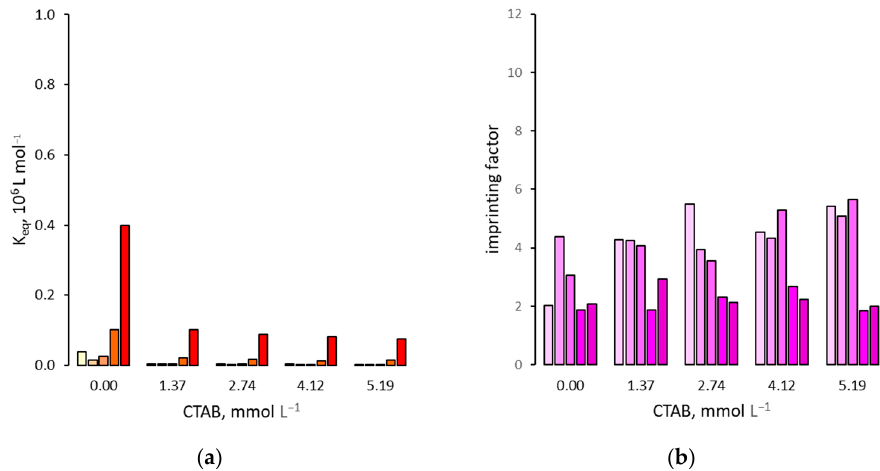
Figure 6. ( a ) Binding affinity of 2,4,5-T for the NIP in presence of increasing amounts of CTAB; ( b ) Imprinting factor. For each group of bars from left to right: water molar fraction from 0 (pure acetonitrile) to 0.24, 0.42, 0.66 and 0.81.